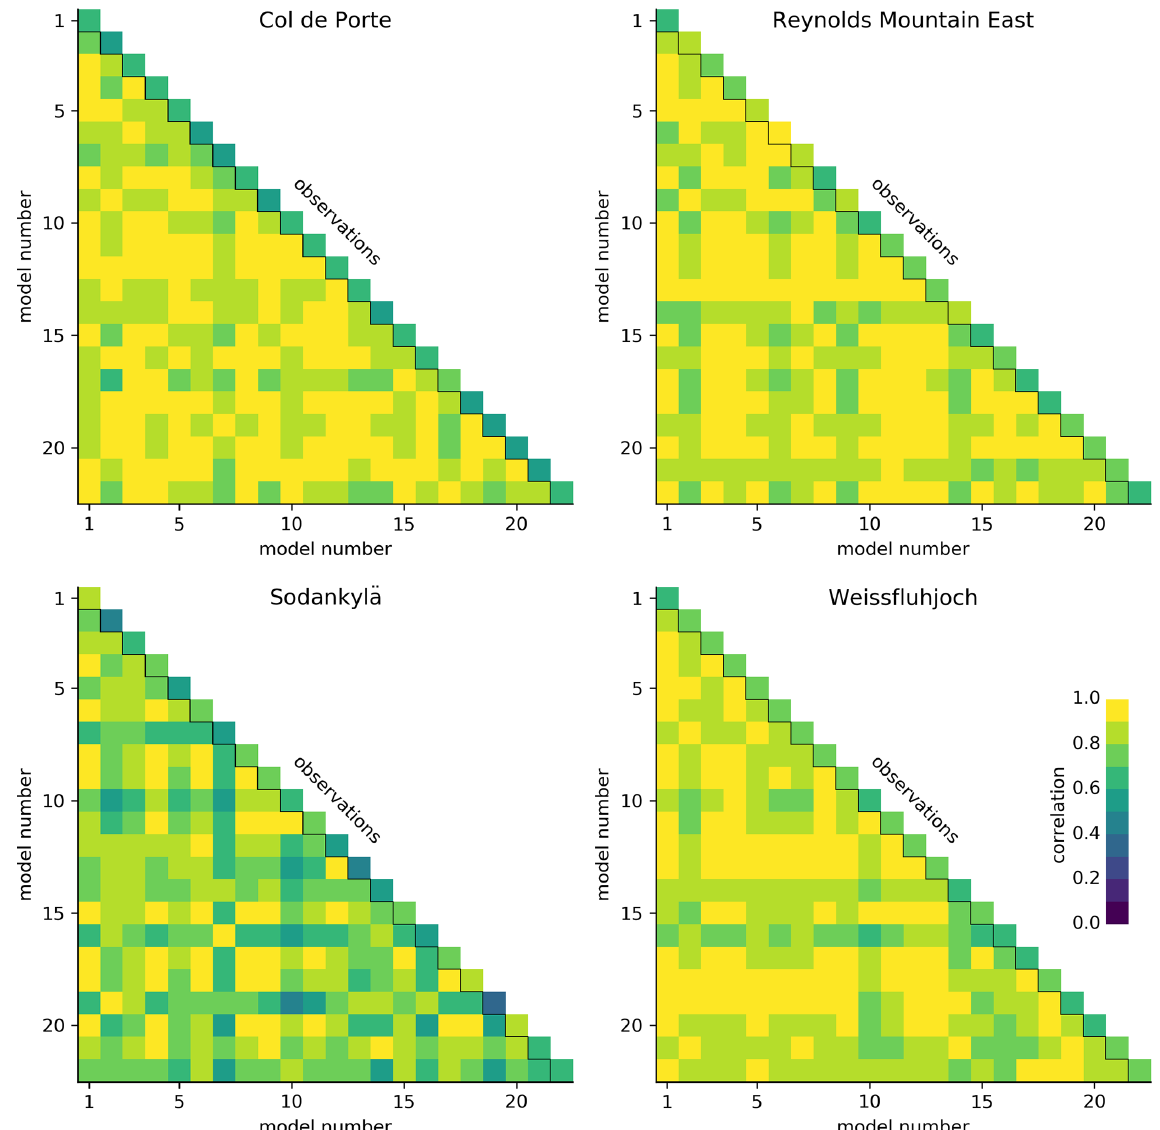
Figure A2. Correlations in interannual variations in snow cover duration between pairs of ESM-SnowMIP models. The upper diagonal in each figure shows correlations between individual models and observations at the